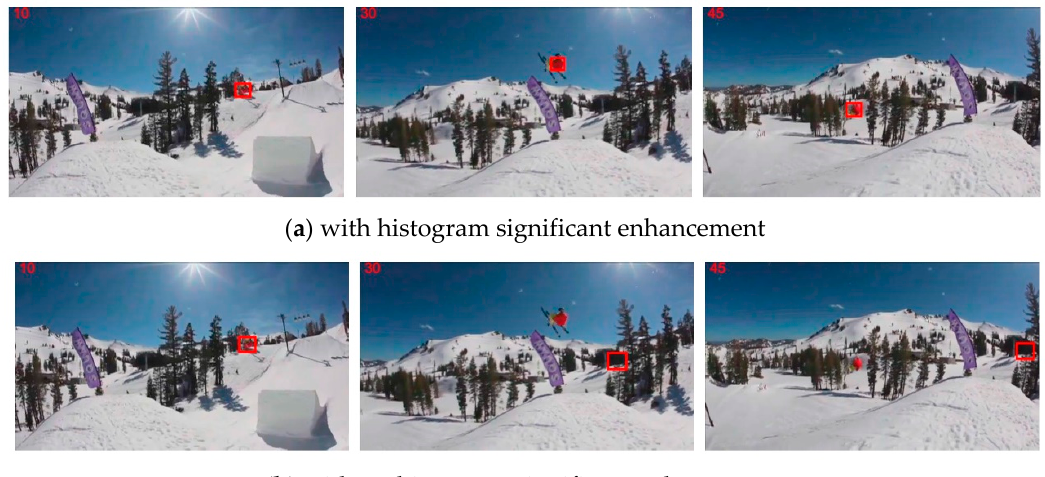
Figure 2. Tracking result of trackers with and without histogram enhancement.